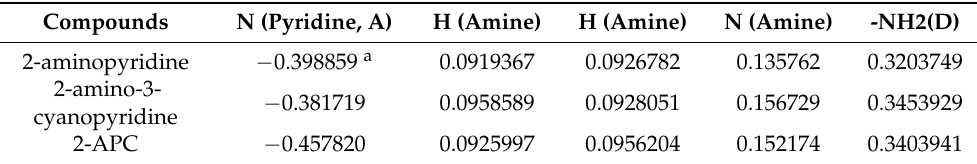
Table 1. The net charge of the proton donor and acceptor of 2-aminopyridine, 2-amino-3- cyanopyridine and